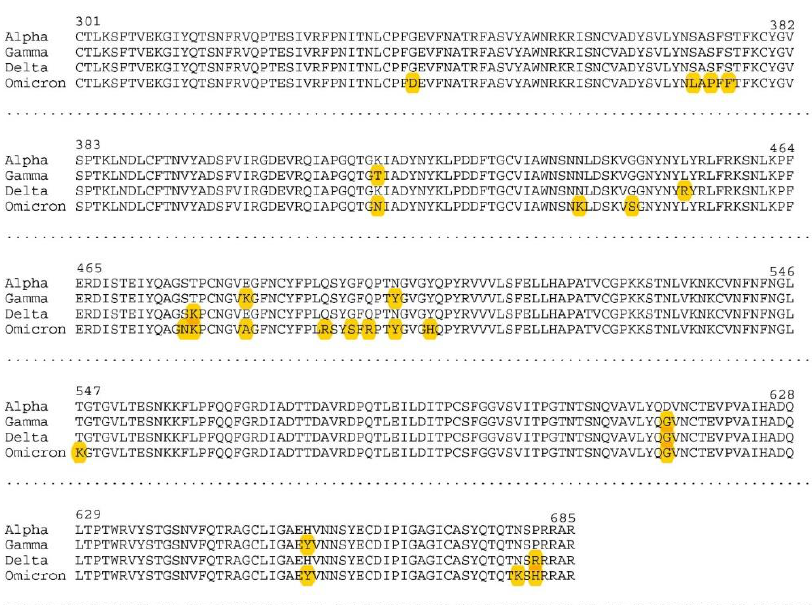
Figure 2. Alignment of the RBD part of the spike protein of SARS-CoV-2, with amino acid changes indicated in yellow when comparing variants Gamma, Delta, and Omicron with Alpha.